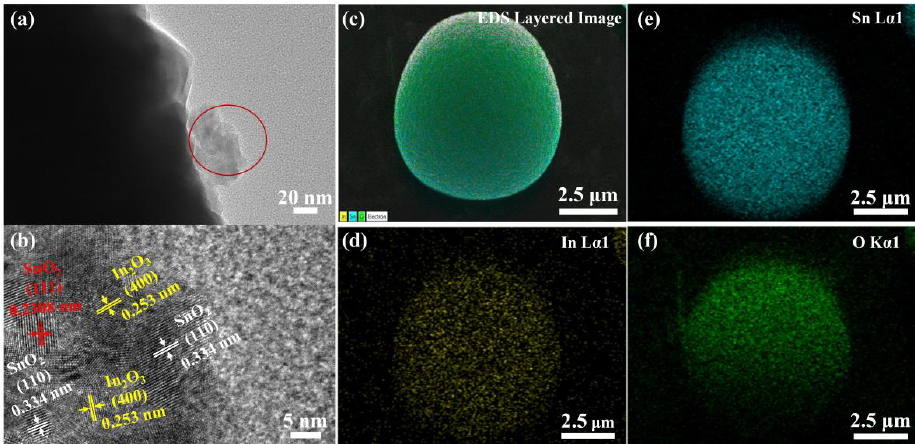
Figure 3. TEM image: ( a ) of the prepared 1.0 wt.% In 2 O 3 /SnO 2 composite photocatalysts; ( b ) HRTEM images; TEM–EDS elemental mapping of 1.0 wt.% In 2 O 3 /SnO 2 composite photocatalysts: ( c ) EDS layered image; ( d ) In Lα1; ( e ) Sn Lα1; ( f ) O Kα1.